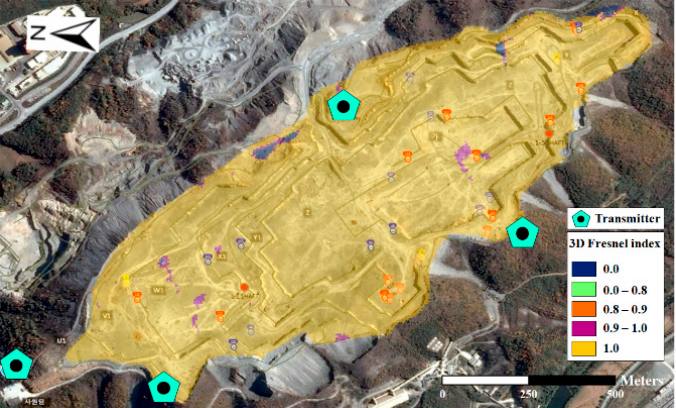
Figure 14. 3D Fresnel index overlay map for the four transmitters in the open-pit mine.